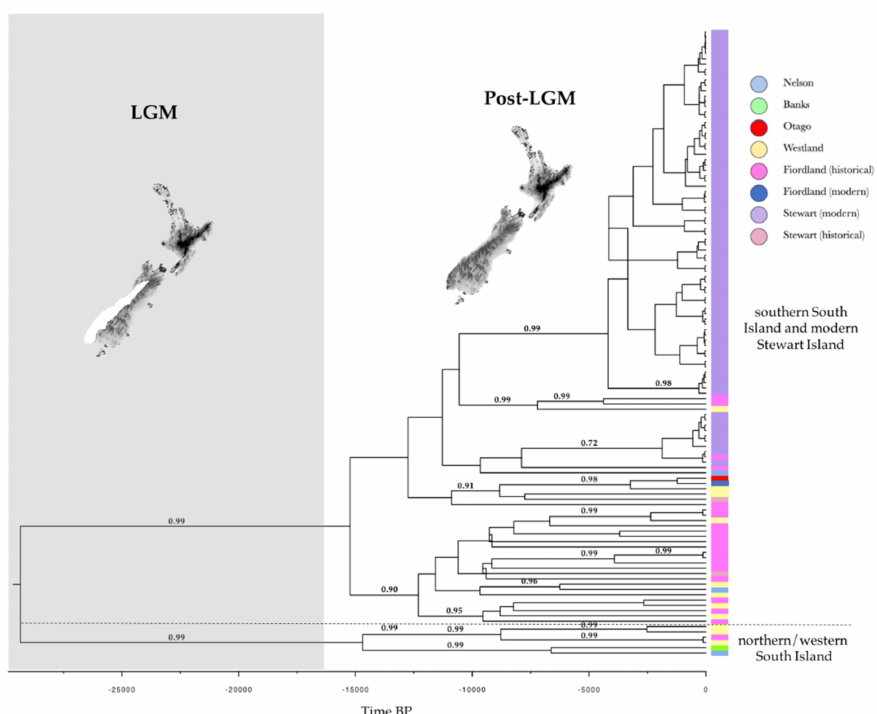
Figure 2. Bayesian phylogeny in k¯ak¯ap¯o for full mitogenomes (16,588 bp). Timing of events was estimated assuming a substitution rate of 1–3 × 10 − 8 site − 1 year − 1 [39]. The x -axis is in calendar years before present and nodes with posterior probability larger than 0.7 are depicted. Maps show the extent of ice during (white) and after the last glacial maximum (LGM) (after [49]).